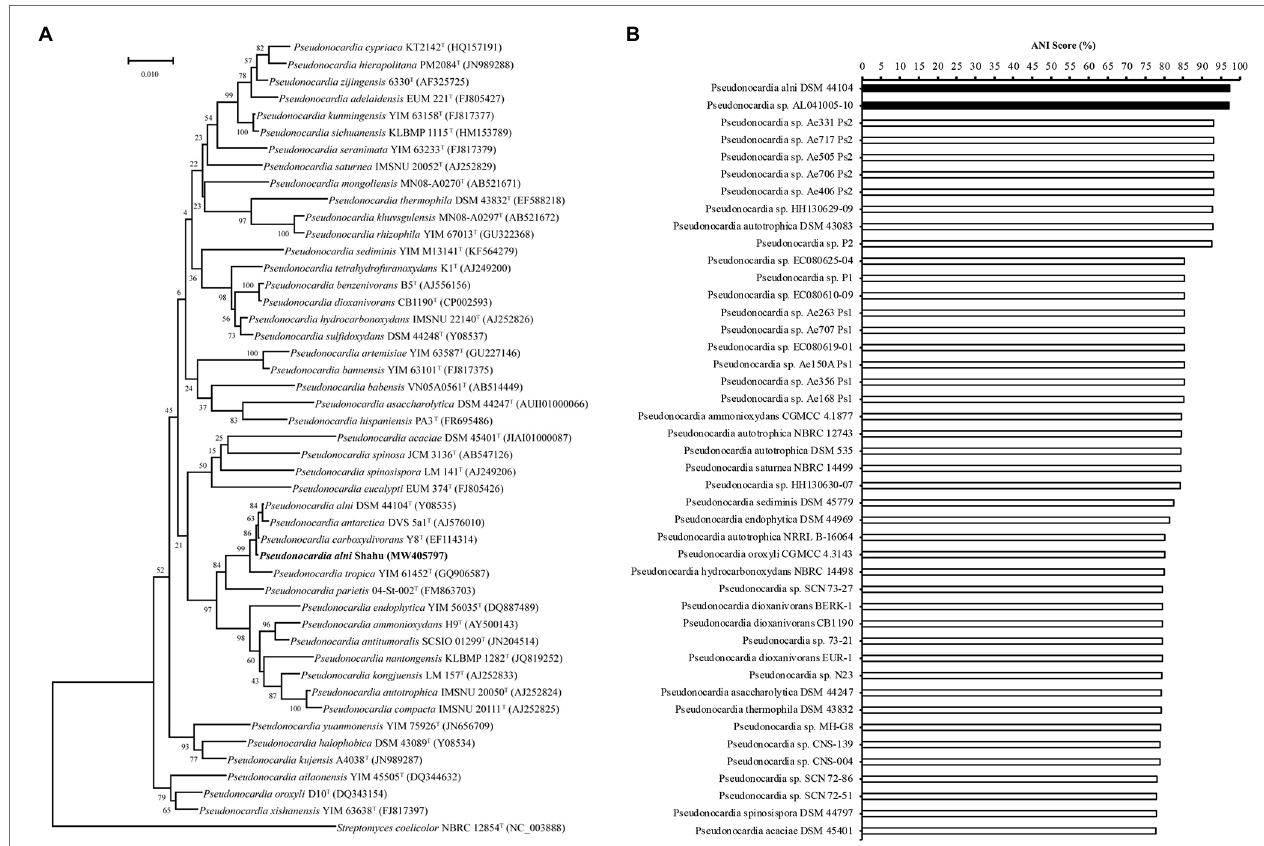
FIGURE 1 | Identification of Pseudonocardia alni Shahu. (A) Neighbor-joining phylogenetic tree based on 16S rDNA sequences showing the phylogenetic relationships of P. anli Shahu and the selected Pseudonocardia species. Streptomyces coelicolor NBRC 12854 T represents an outgroup reference. (B) Taxonomic analysis of P. anli Shahu with genomes of Pseudonocardia available in the NCBI Genome database. Pairwise Average Nucleotide Identity (ANI) score was estimated, and ANI score over 95% indicated with filled bars.